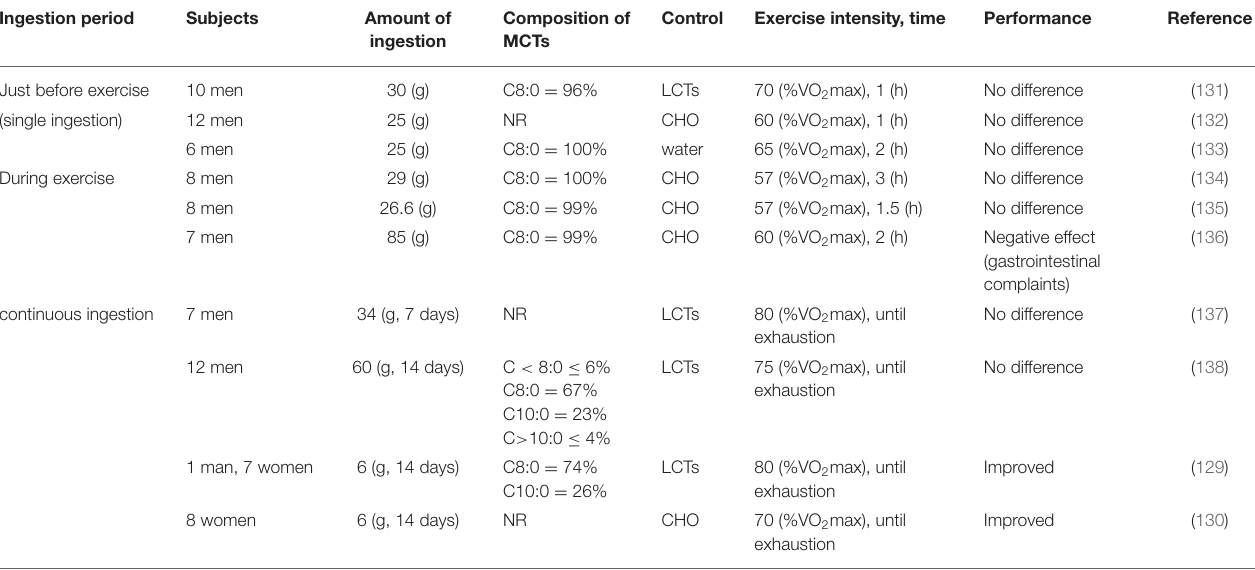
TABLE 3 | Effect of MCTs on performance during exercise. Ingestion period Subjects Amount of